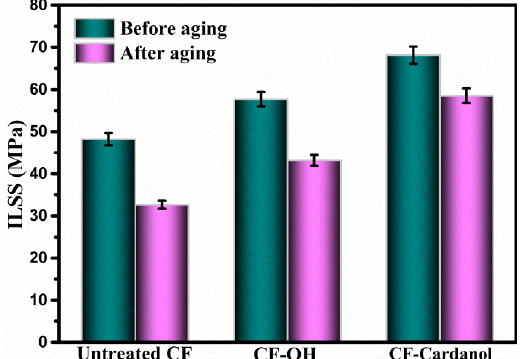
Figure 7. ILSS of composites before and after hydrothermal aging treatment.